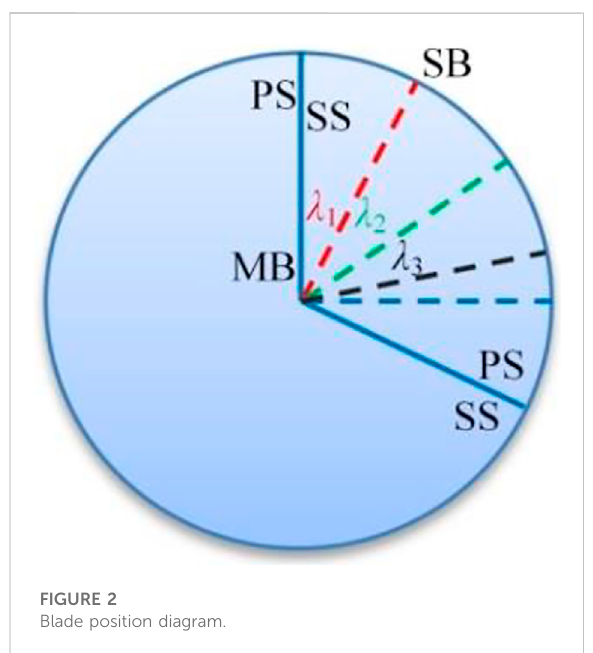
FIGURE 2 Blade position